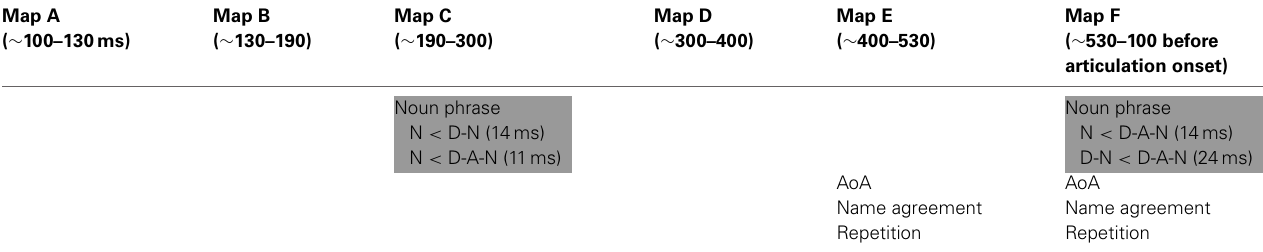
Table 4 | Summary of the effects of utterance format (in grey) and of other predictors for each topographic map. Map